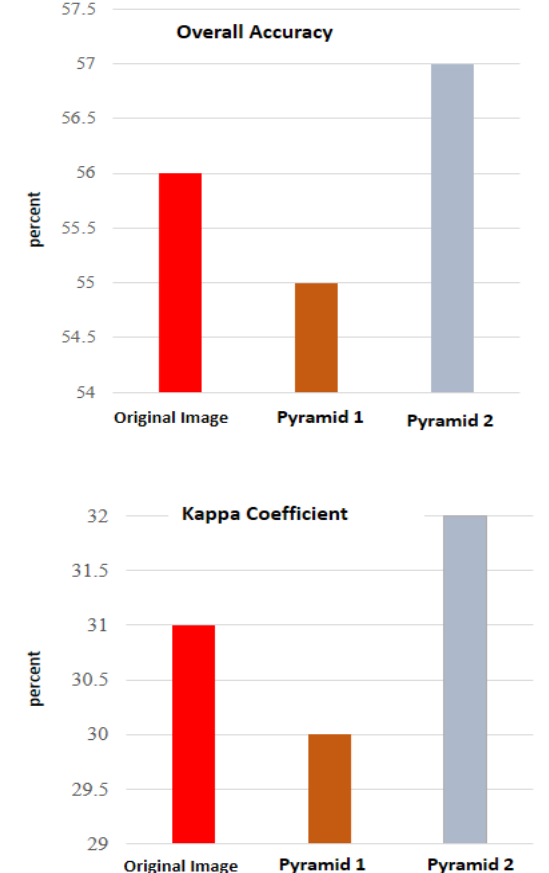
Figure 6. Kappa Coefficient and overall accuracy values on the different spatial resolutions of the first selected band of the data set